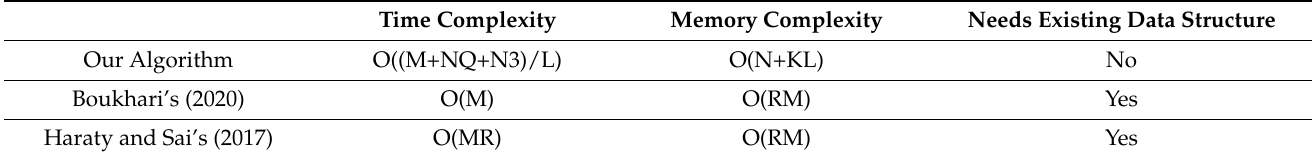
Table 1. Comparison of the three algorithms considered in the experiments. The time complexity does not account for the time to build the needed data structures. M = total number of transactions; N = number of malicious and affected transactions; R = number of transactions that the transactions depend on; L = number of threads or areas; K = number of transactions handled by one thread or in one area; and Q = time to check dependency between transactions. Time Complexity Memory Complexity Needs Existing Data Structure Our Algorithm O((M+NQ+N3)/L) Boukhari’s (2020) Haraty and Sai’s